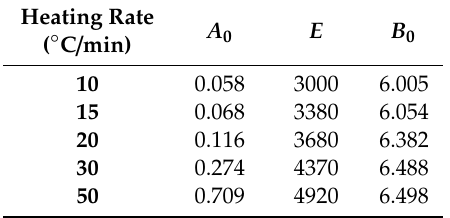
Table 2. Reaction parameters of polymerization kinetics at di ff erent heating